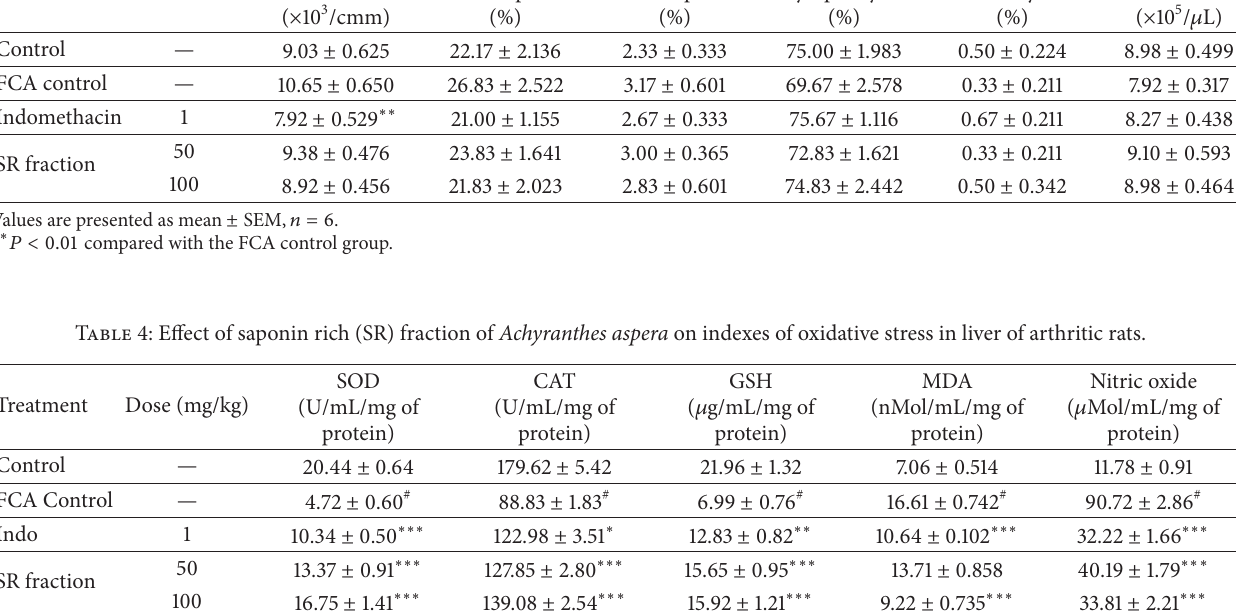
Table 3: Effect of saponin rich (SR) fraction of Achyranthes aspera on total and differential leucocyte count of arthritic rats. Treatment